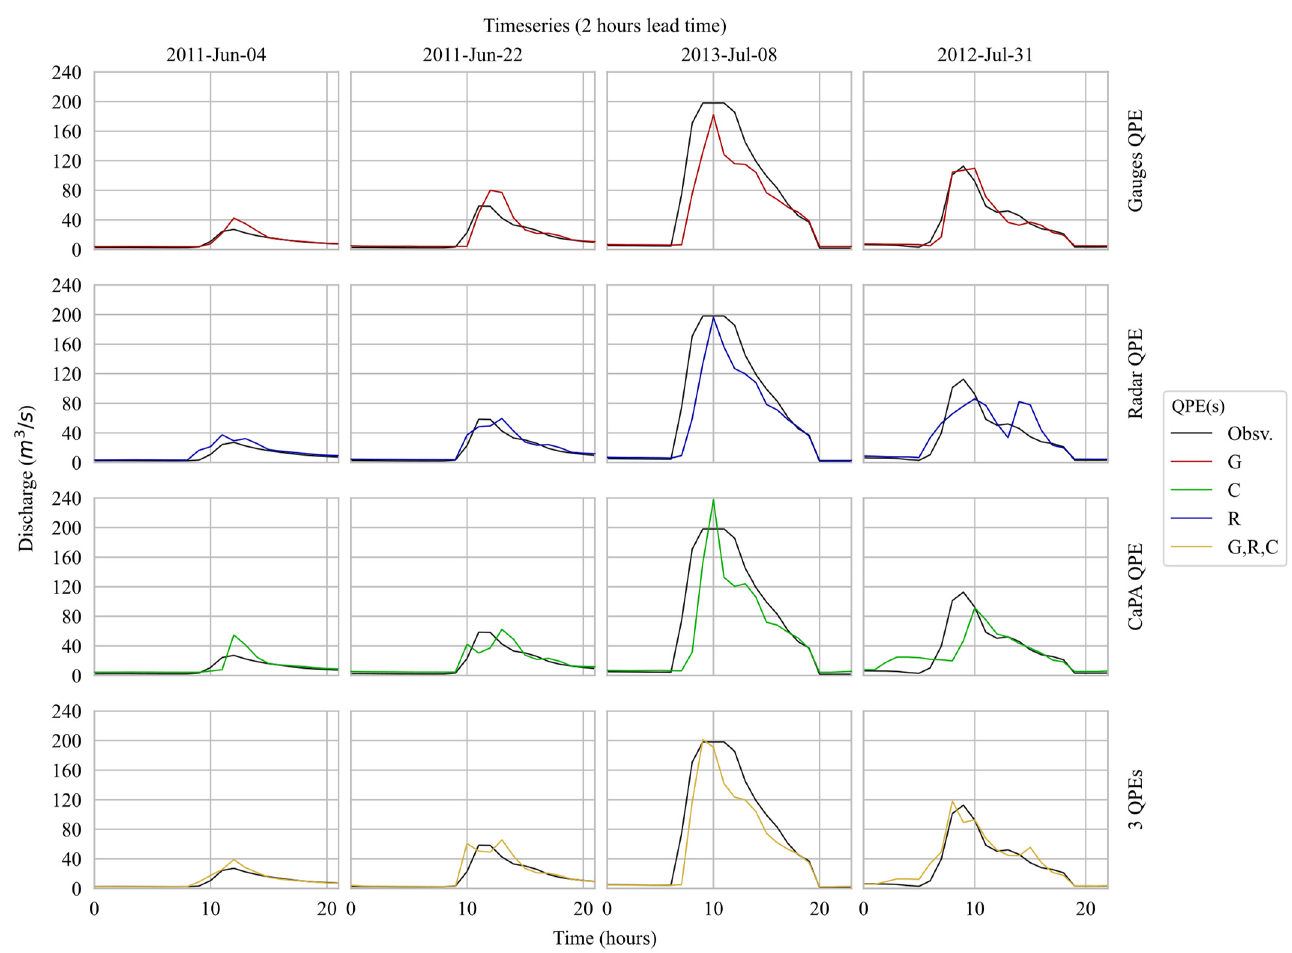
Figure 10. Observed hydrographs of selected events and their respective predictions at 2 h lead time.